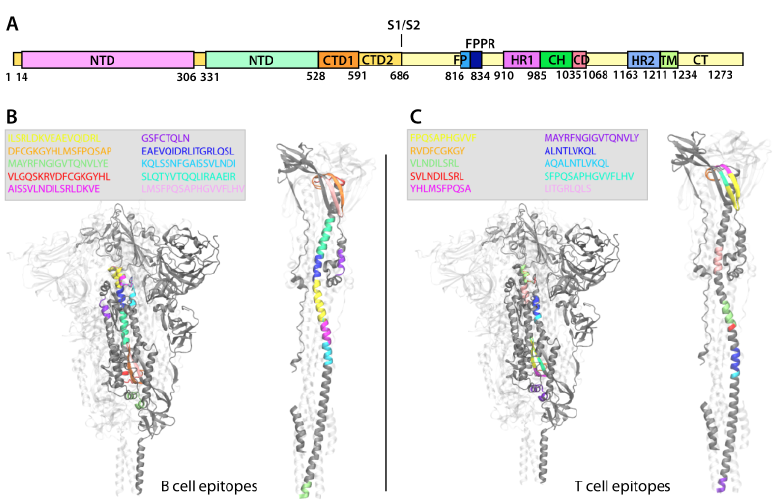
Figure 5. Representation of the localization of the B cell and T cell epitopes on the SARS-CoV-2 Spike glycoprotein in the prefusion and postfusion conformations. ( A ) Scheme of SARS-CoV-2 S1 and S2 units of the S protein and of their domains. ( B , C ) The S protein trimer is represented in New Cartoon format (one monomer is gray the other two are transparent) and is shown in the prefusion conformation in the left side of the panels and in the postfusion conformation on the right side of the panels. The sequence of the B cell ( A ) and T cell ( B ) epitopes is shown in the figure legend and is colored accordingly in the S protein